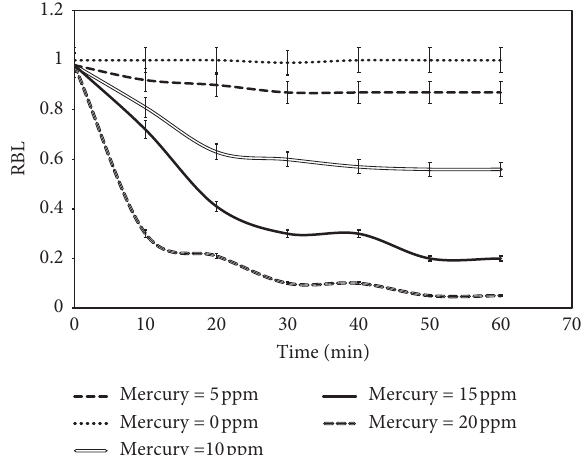
Figure 11: The variation of RBL with time for the biosensor system for different mercury concentrations (Aeration rate: 20ml/min, T � 37 °